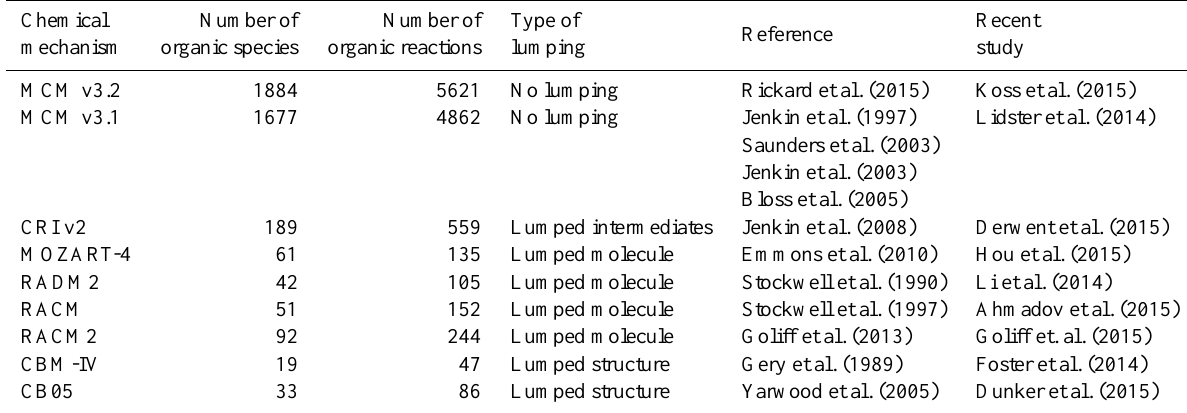
Table 1. The chemical mechanisms used in the study are shown here. MCM v3.2 is the reference mechanism. The number of organic species and reactions needed to fully oxidise the VOCs in Table 2 for each mechanism are also